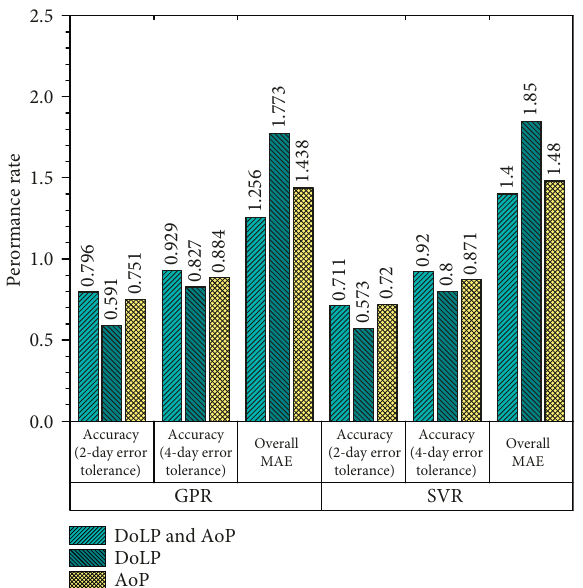
Figure 3: Performance comparison of support vector regression and Gaussian process for different classifier